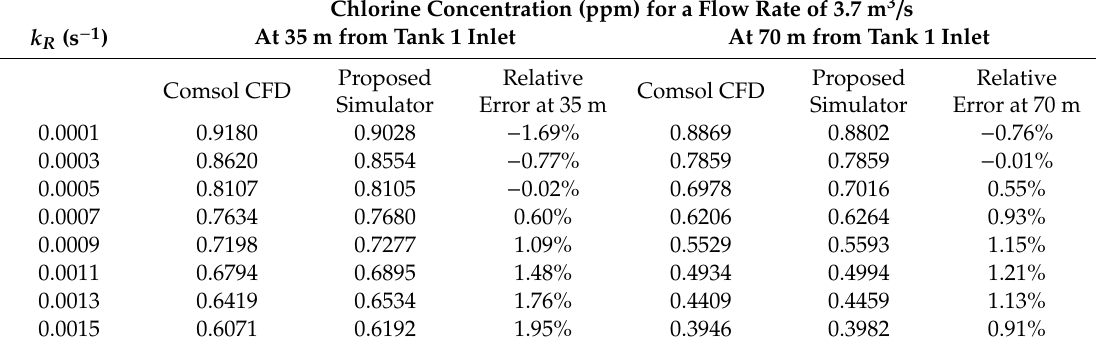
Table 2. Comparison of chlorine decay between the simulator and the Comsol computational fluid dynamics (CFD).